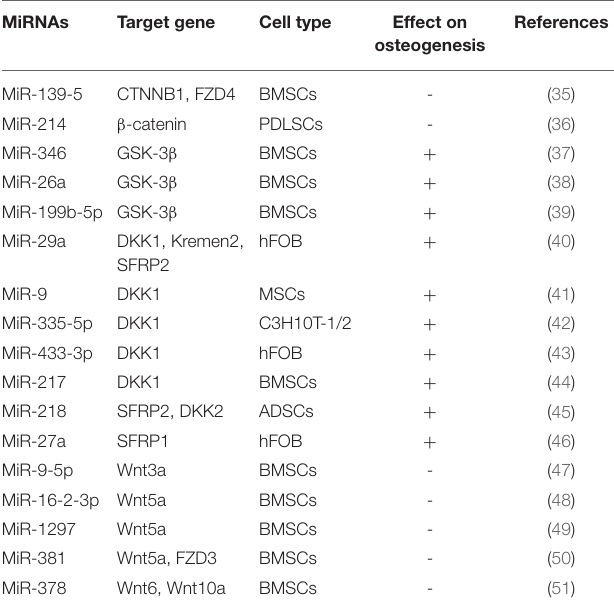
TABLE 1 | MiRNAs regulate osteogenic differentiation by Wnt signaling